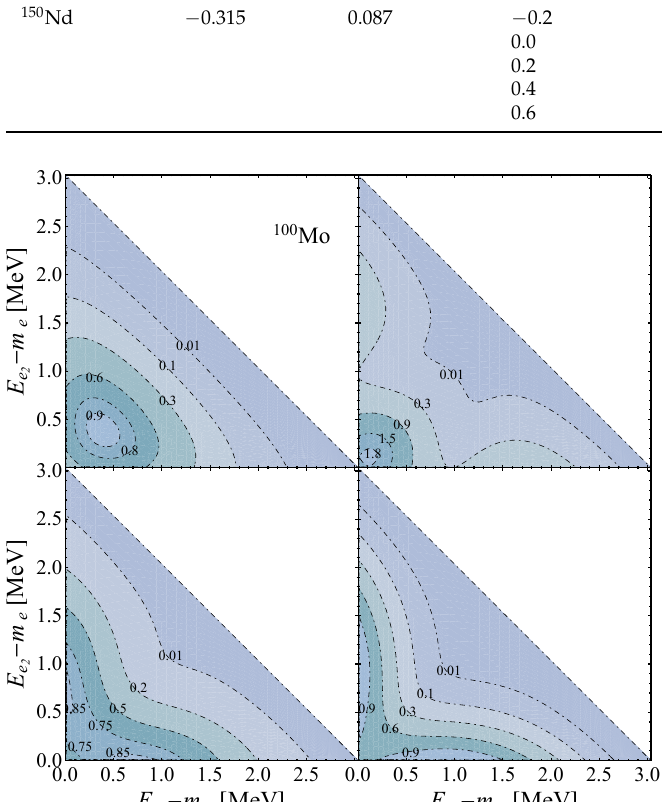
)) , as func- dE e 2 1